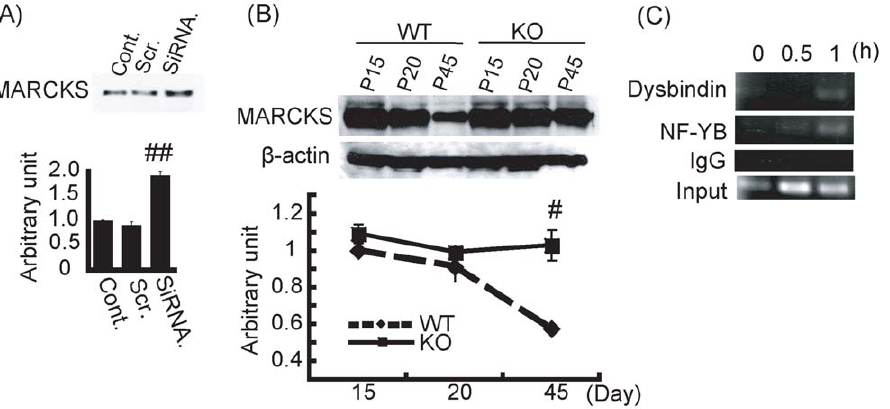
Figure 3. The effects of Dysbindin on MARCKS expression levels. (A) SH-SY5Y cells were transfected with scrambled siRNA or siRNA for Dysbindin. Cell lysate of non-treated cells (Cont.), scrambled RNAi-transfected cells (Scr.) and RNAi for Dysbindin-transfected cells (siRNA) were subjected to Western blot with anti-MARCKS antibody. Columns and vertical bars denote the means 6 SEM (triplicate independent experiments). Dysbindin knockdown cells exhibited significant reduction of MARCKS expression compared with control cells ( P , 0.001, Student’s t-test). (B) Hippocampus lysates were collected from wild-type mice or Dysbindin KO mice at P15, P20 and P45. The lysates were subjected to Western blot with anti-MARCKS antibody. Graphs and vertical bars denote the means 6 SEM (triplicate independent experiments). At P45, Wild-type mice showed significant decreased MARCKS expression, while Dysbindin KO mice showed a maintained MARCKS expression. These data were confirmed by triplicate independent experiments (P , 0.01, Student’s t-test). ( C )Chromatin IP (ChIP) was performed using SH-SY5Y cells under the stimulation of retinoic acid. The promoter region of MARCKS was detected both in the IPs of anti-Dysbindin antibody (1 st panel) and those of anti-NF-YB antibody (2 nd panel), but not in the IPs of IgG (3 rd